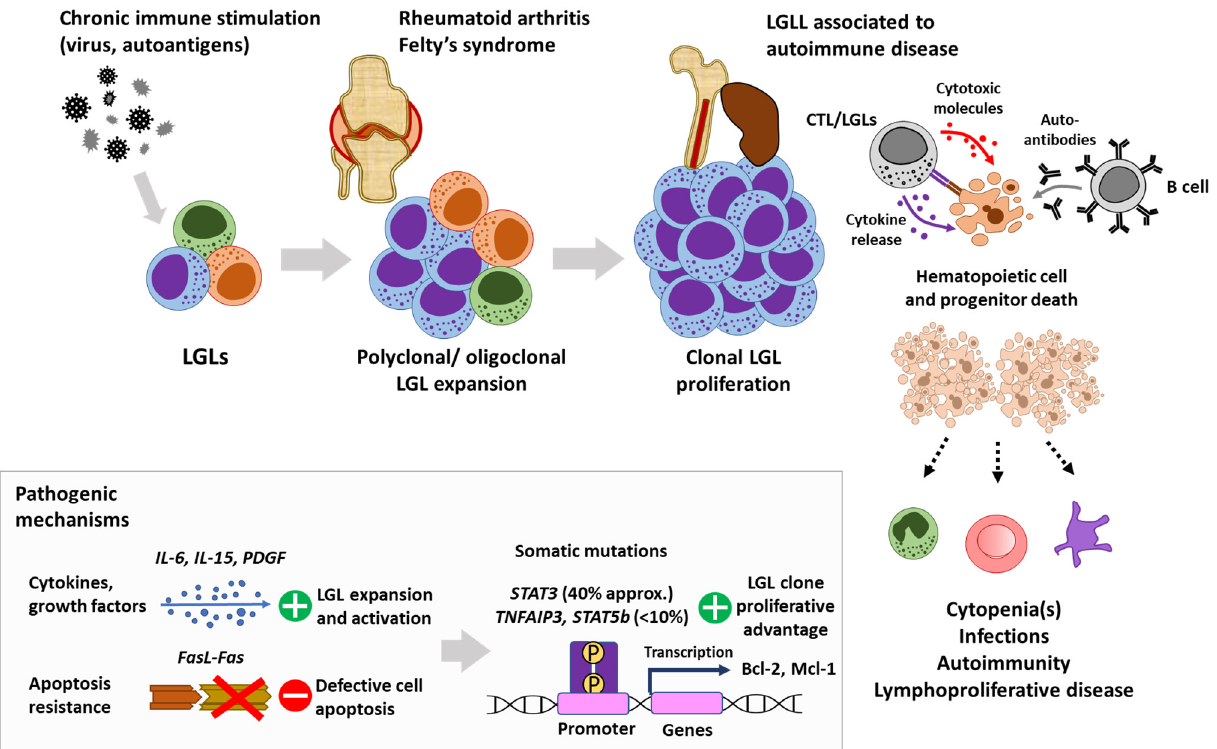
Figure 1. Proposed common etiopathogenesis for LGLL associated with autoimmune disease. FasL: fas ligand. IL: interleukin. PDGF: platelet-derived growth factor. LGL: large granular lymphocytes. LGLL: large granular lymphocytic leukemia. STAT : signal transducer and activator of transcription. TNFAIP3 : tumor necrosis factor alpha-induced protein 3.